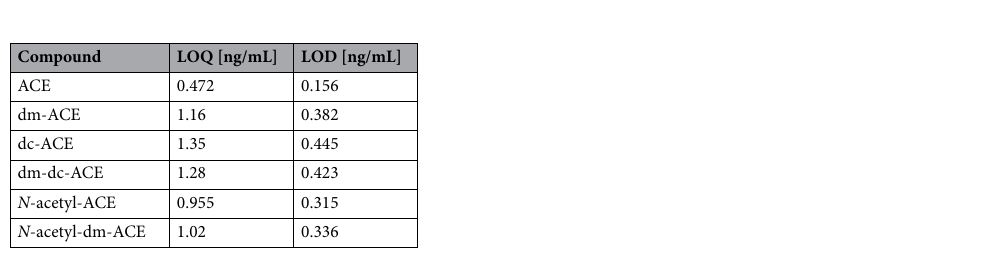
Table 2. LOQ and LOD of ACE and its metabolites. Abbreviations: LOQ Limit of quantitation, LOD Limit of detection, ACE acetamiprid, dm-ACE Acetamiprid-N-desmethyl, dc-ACE N-descyano-acetamiprid.